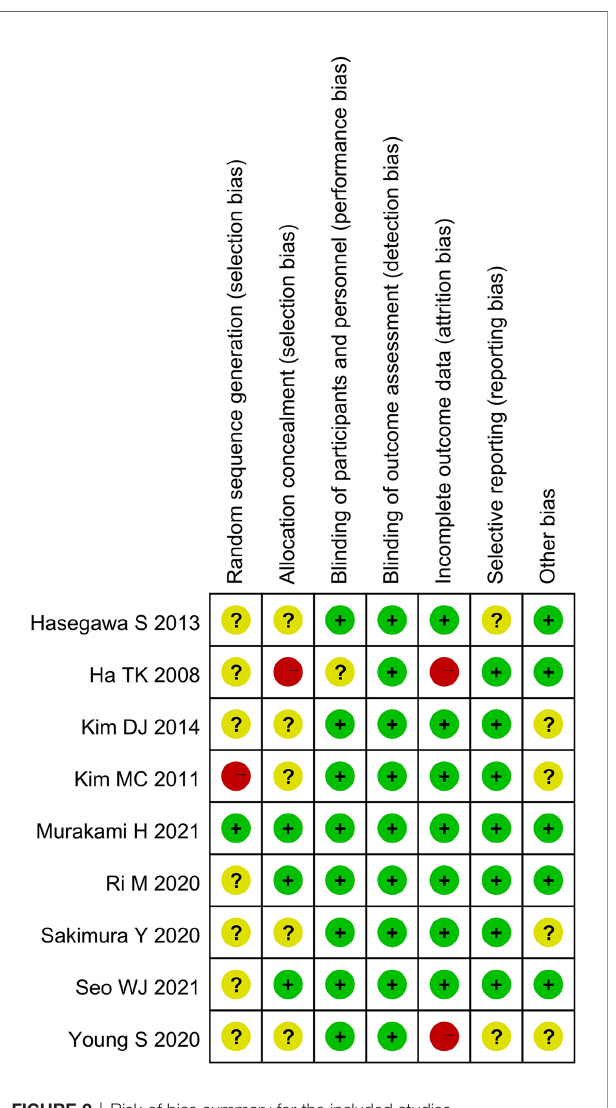
FIGURE 2 | Risk of bias summary for the included studies.